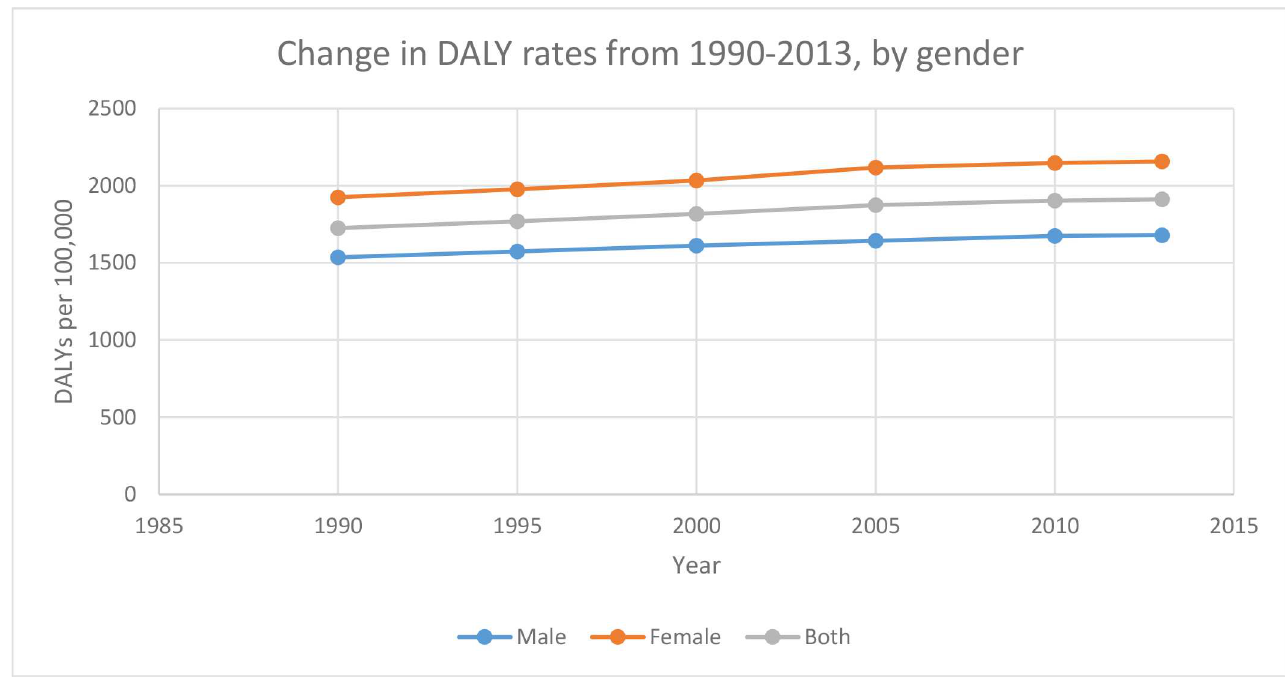
Fig 4. Change in DALY rates from 1990–2013,by gender.